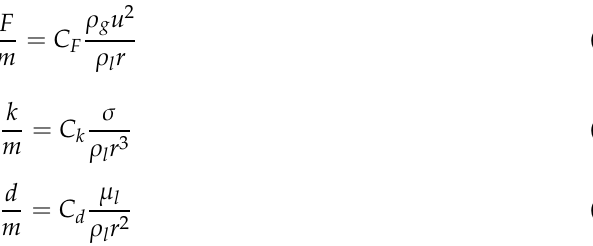
Figure 3. External flow field of the nozzle.